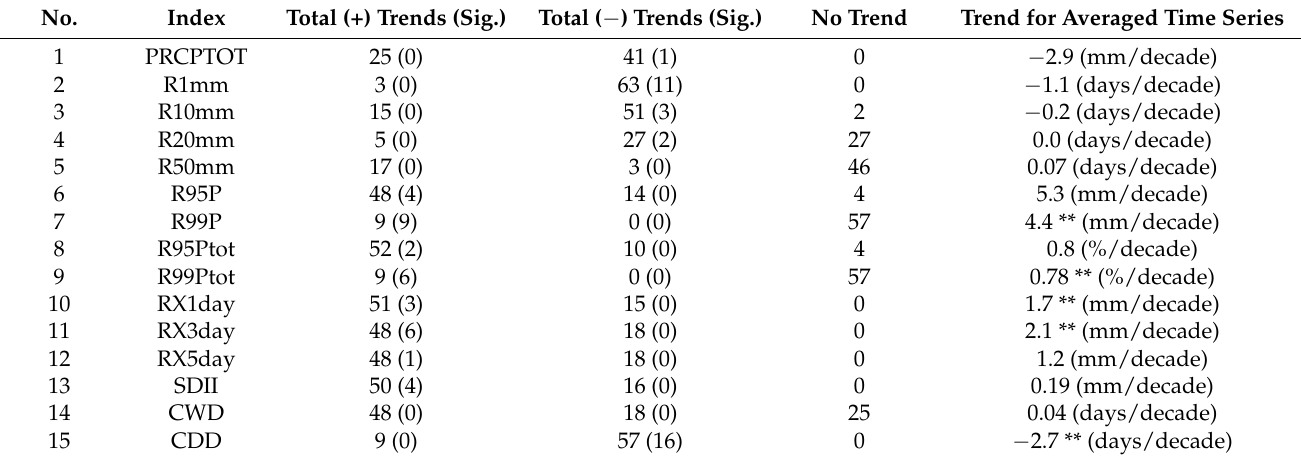
Table 2. Number of stations that showed increasing or decreasing trend along with the trend values for the annual extreme indices averaged over the study area, during the period 1970–2020. The number in brackets represents the counts of stations with statistically significant trends at the 95% confidence level. Asterisks indicate significance level: ** = ( p < 0.05).